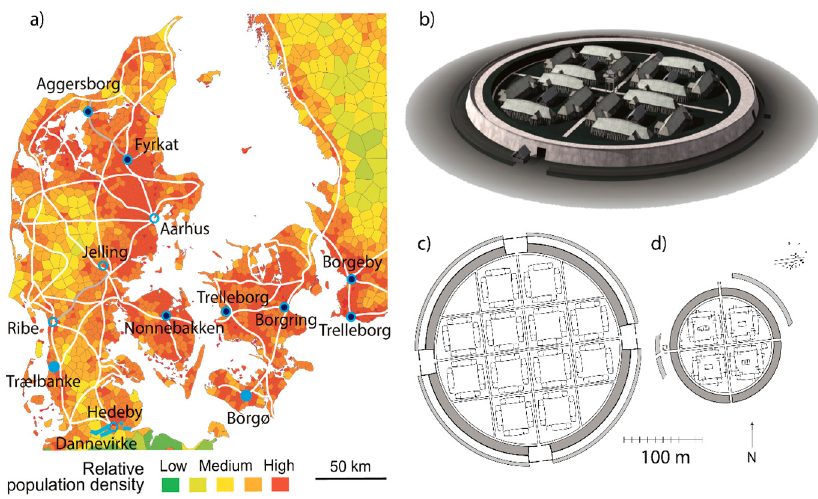
Figure 1. Confirmed and new candidates for Viking Age military installations and ring fortresses on the map of Denmark and adjacent areas of present-day Germany and Sweden showing estimates of relative late Viking Age human (10th Century CE) population density [17], the confirmed Viking Age ring fortresses (blue-black circles), contemporary fortified cities, and the royal center in UNESCO World Heritage site Jelling (open blue) [6], the fully developed linear defensive earthwork across the southern frontier, the UNESCO World Heritage site Dannevirke, and the two new candidate sites, Trælbanke and Borgø (larger blue circles), from the automatic feature detection ( a ), archaeological reconstruction of the Fyrkat ring fortress ( b ), and an example of plans of recognized ring fortresses Aggersborg ( c ), and Fyrkat ( d ) [6,8].